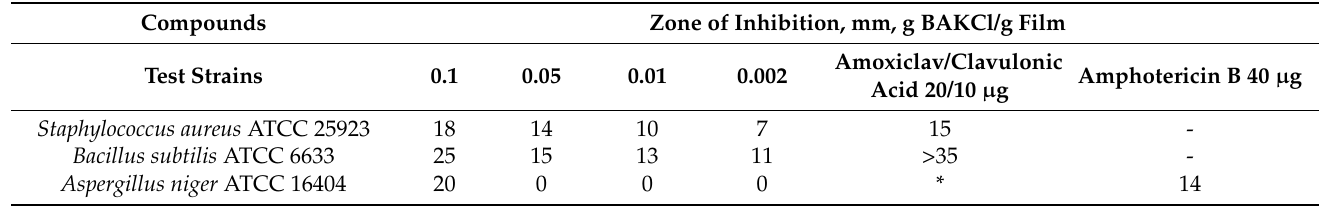
Table 2. The antimicrobial activity of the films with BAKCl was measured by disc diffusion assay. Compounds Zone of Inhibition, mm, g BAKCl/g Film Amoxiclav/Clavulonic Amphotericin B 40 µ g Test Strains 0.1 0.05 0.01 0.002 Acid 20/10 µ g Staphylococcus aureus ATCC 25923 18 14 10 7 15 - Bacillus subtilis ATCC 6633 25 15 13 11 >35 - Aspergillus niger ATCC 16404 20 0 0